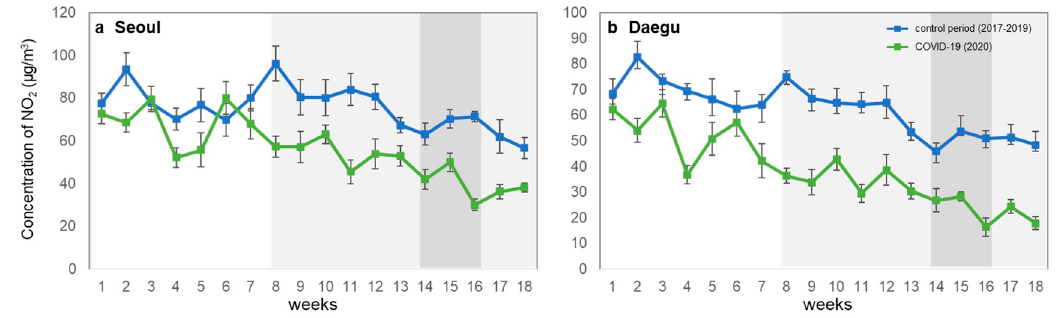
Figure 6. Comparison of average NO 2 concentrations by week between 2020 and the previous three years in ( a ) Seoul and ( b ) Daegu. Highlighted shadow represents the level of social distancing. The error bar means standard deviation.